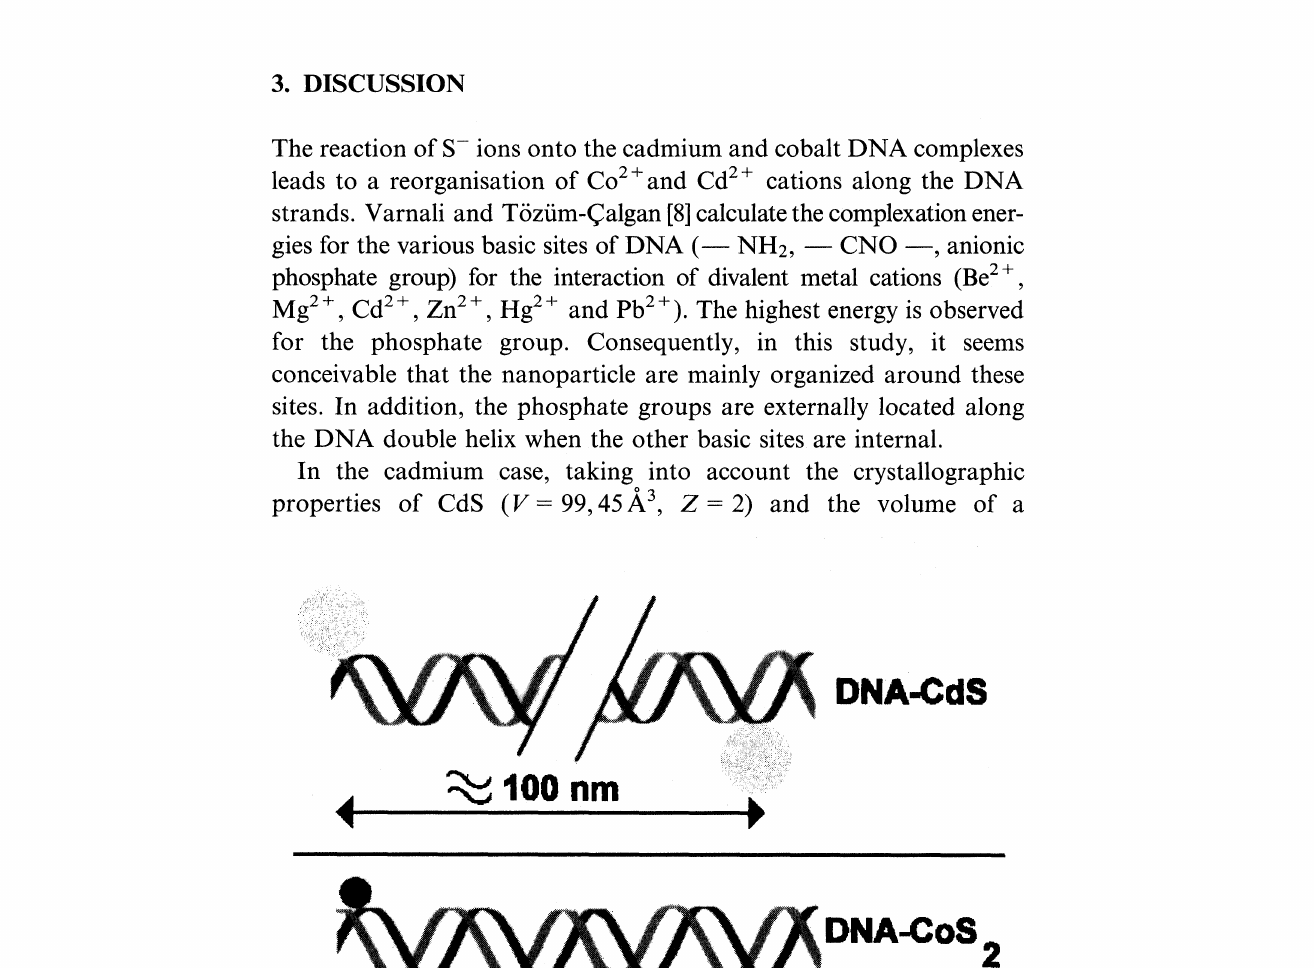
FIGURE 3 Possible organisation of CdS and CoS nanoparticles along double strand